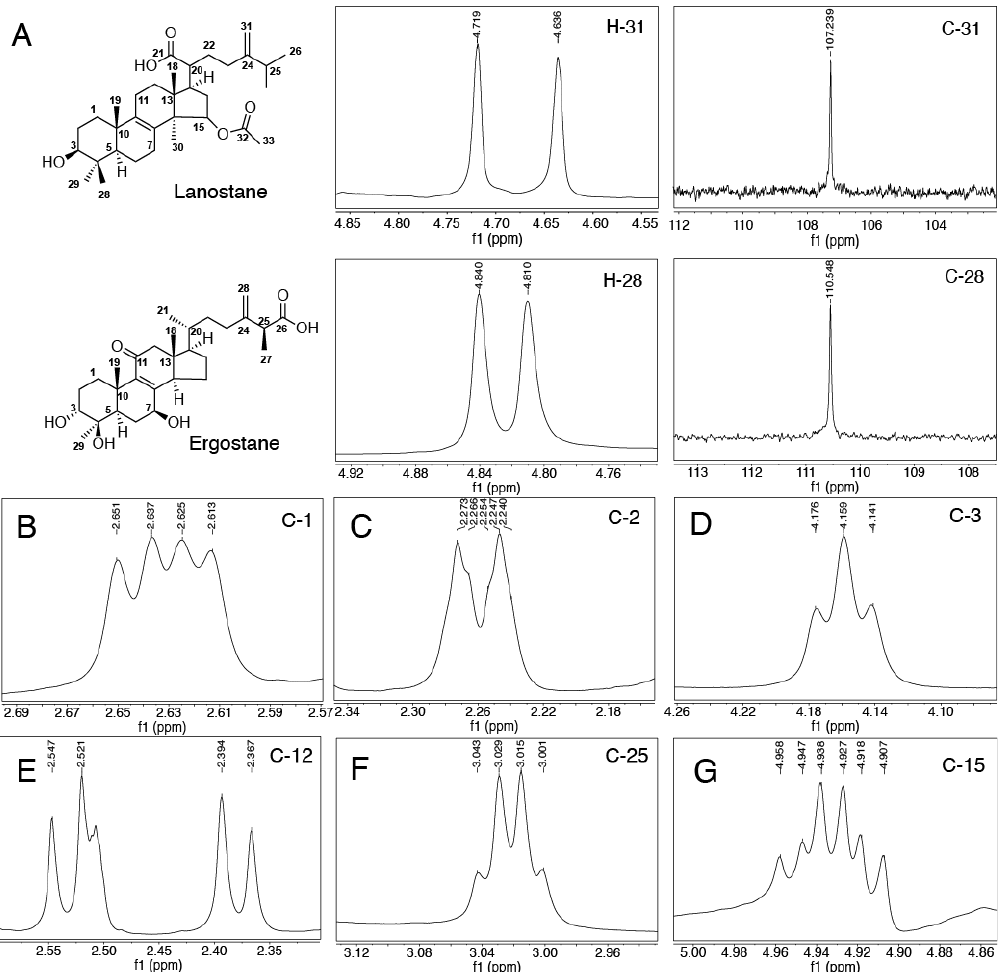
Figure 3. Structural characterization of ergostane-type and lanostane-type triterpenoids. ( A ) 1 H NMR resonance for H − 3 and 13 C NMR resonance for C-3. The characteristic NMR signal of C1 of (25S)-Antcin K is shown in ( B ), C2, C3, C12, C25 and C15 in ( C ), ( D ), ( E ), ( F ) and ( G